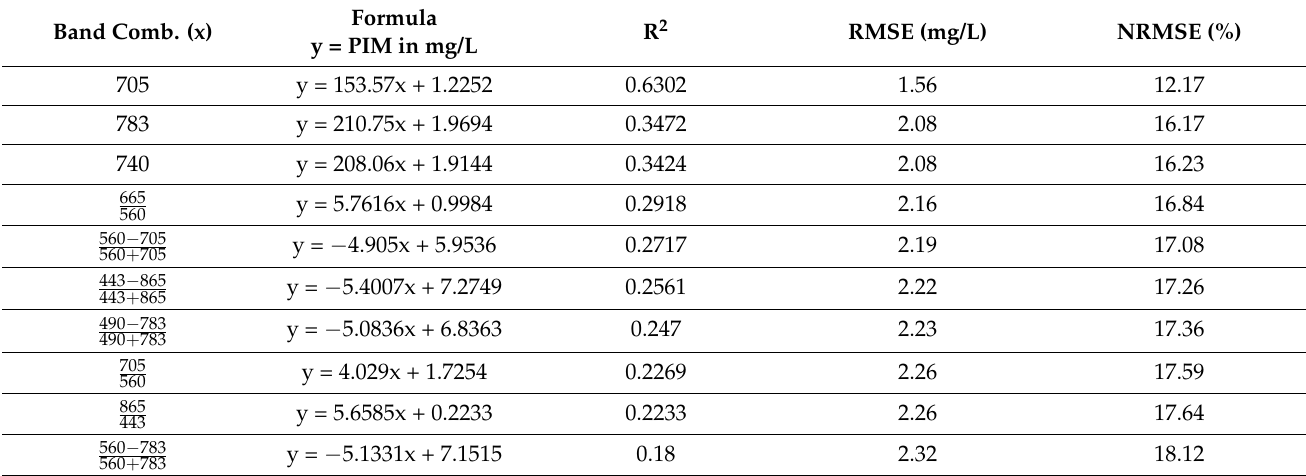
Table 4. Algorithm results for PIM. Only the best 10 results are